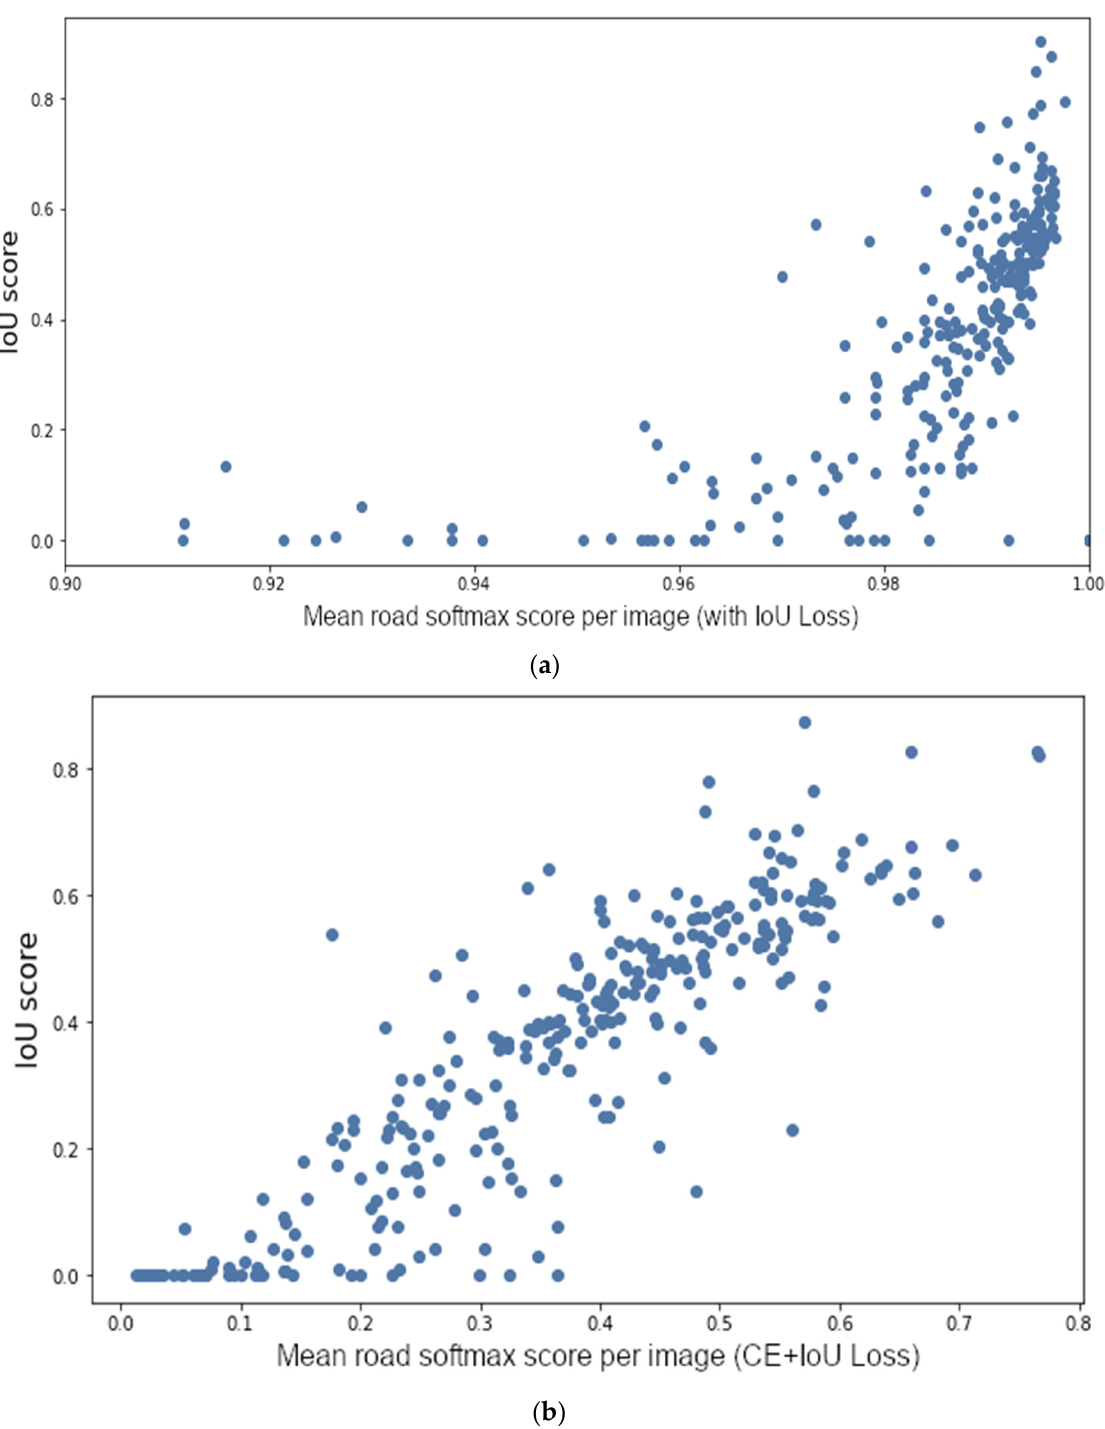
Figure 3. ( a ) The Intersection over Union score is not well calibrated, i.e., image chips with low scores have confident softmax values, despite producing a well-trained model. This is problematic, as it prevents thresholding of low scoring image chips based on network output. ( b ) A loss function composed of the sum of IoU and cross-entropy losses provides a well calibrated threshold ramp, while maintaining model performance.